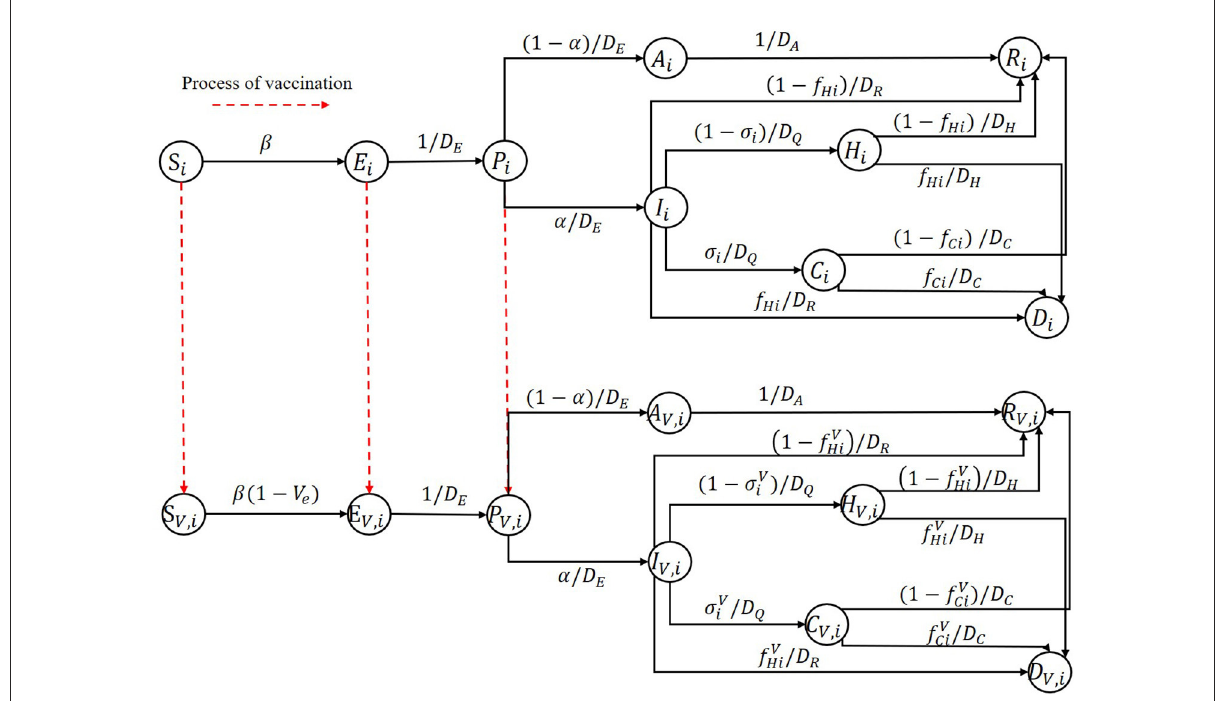
FIGURE2 Illustration diagram of the further extended age-stratified SEIR